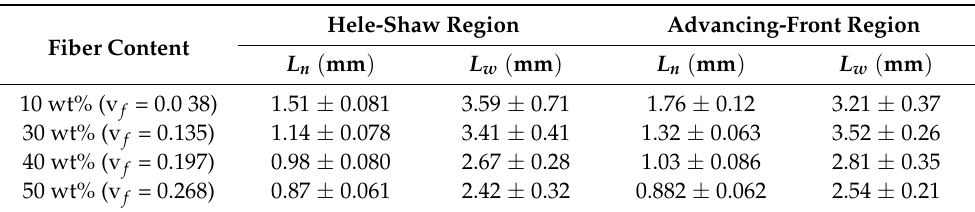
Figure 2. The modified fibers sampling method: ( a ) A needle coated with epoxy inserted into the desired location, and ( b ) the pulled out needle with the fibers attached on the surface of the epoxy. Table 1. Fiber lengths